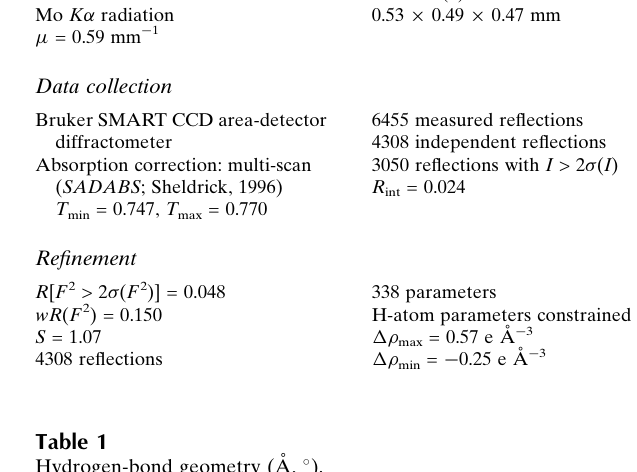
Hydrogen-bond geometry (A˚ , (cid:2)